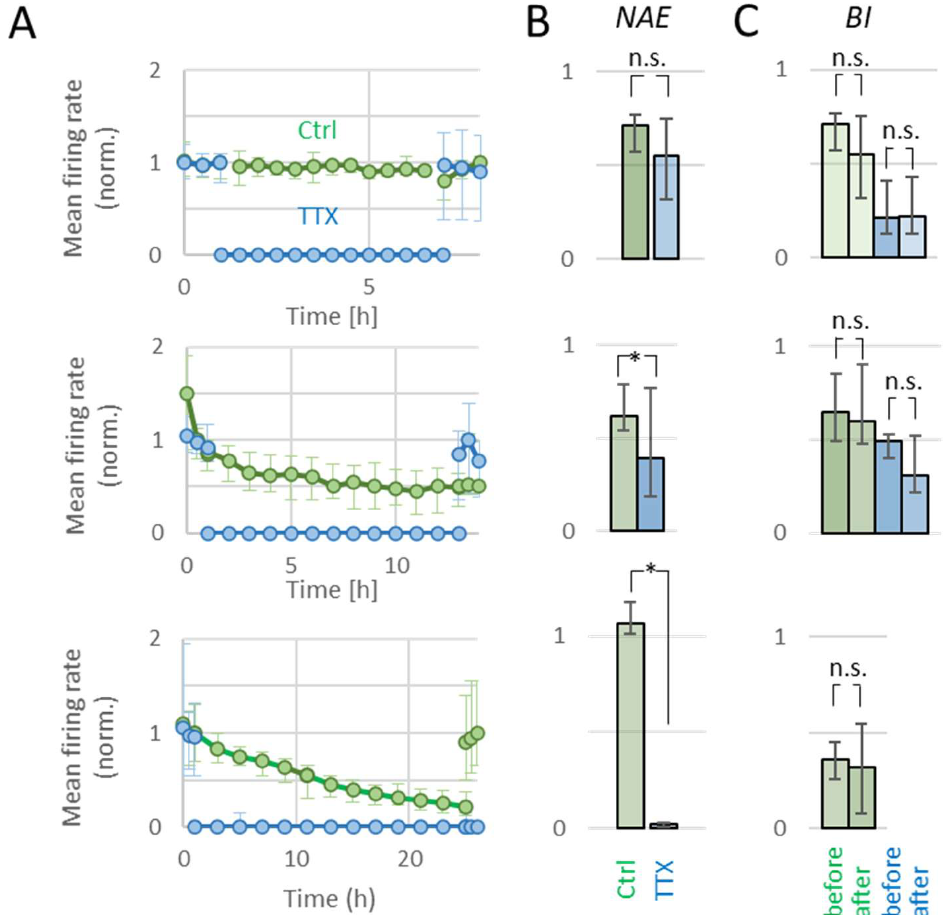
Figure 2. Effect of TTX exposure on neuronal activity. ( A ) Temporal evolution of mean firing rate before, during, and after exposure to TTX (blue) and under control conditions (green), for 6 h (top panel), 12 h (middle), or 24 h (bottom). ( B ) Number of active electrodes ( NAE ) after washout in TTX (blue) and control recordings (green), normalized to NAE during baseline. ( C ) Burstiness index ( BI ) before (left) and after (right) exposure to TTX (blue) or control conditions (green). After 24 h of TTX, there was no recovery of activity and BI could not be determined. * indicates significant difference ( p < 0.05); n.s.: not significant.